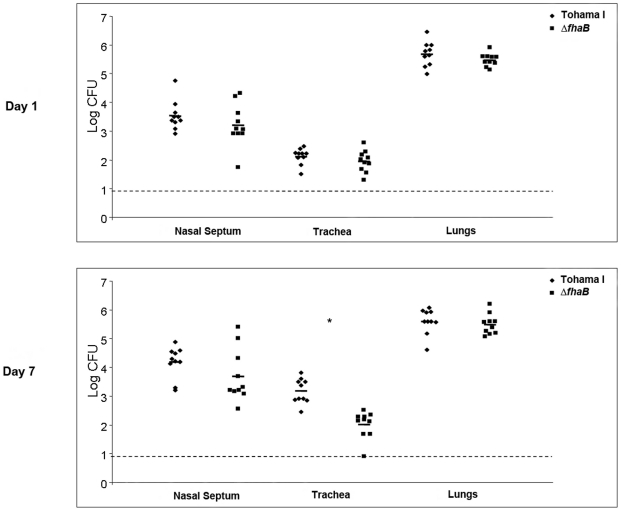
Colonization of the murine respiratory tract by the WT and ΔfhaB strains.Groups of five, 6 to 8 week old C57BL/6 mice were intranasally inoculated with containing 5×105 CFUs of either the WT or the ΔfhaB strain in 50 µl. After 1 (A) or 7 (B) days, mice were sacrificed and colonization was assessed for the nasal septum, trachea, and lungs. Horizontal bars represent the mean for each group. The dashed lines indicate the limit of detection. The experiment was performed in duplicate with all mice from both experiments being represented. An asterisk indicates significant differences between the WT and the ΔfhaB mutant (P value <0.05; unpaired two-tailed Student's t-test).